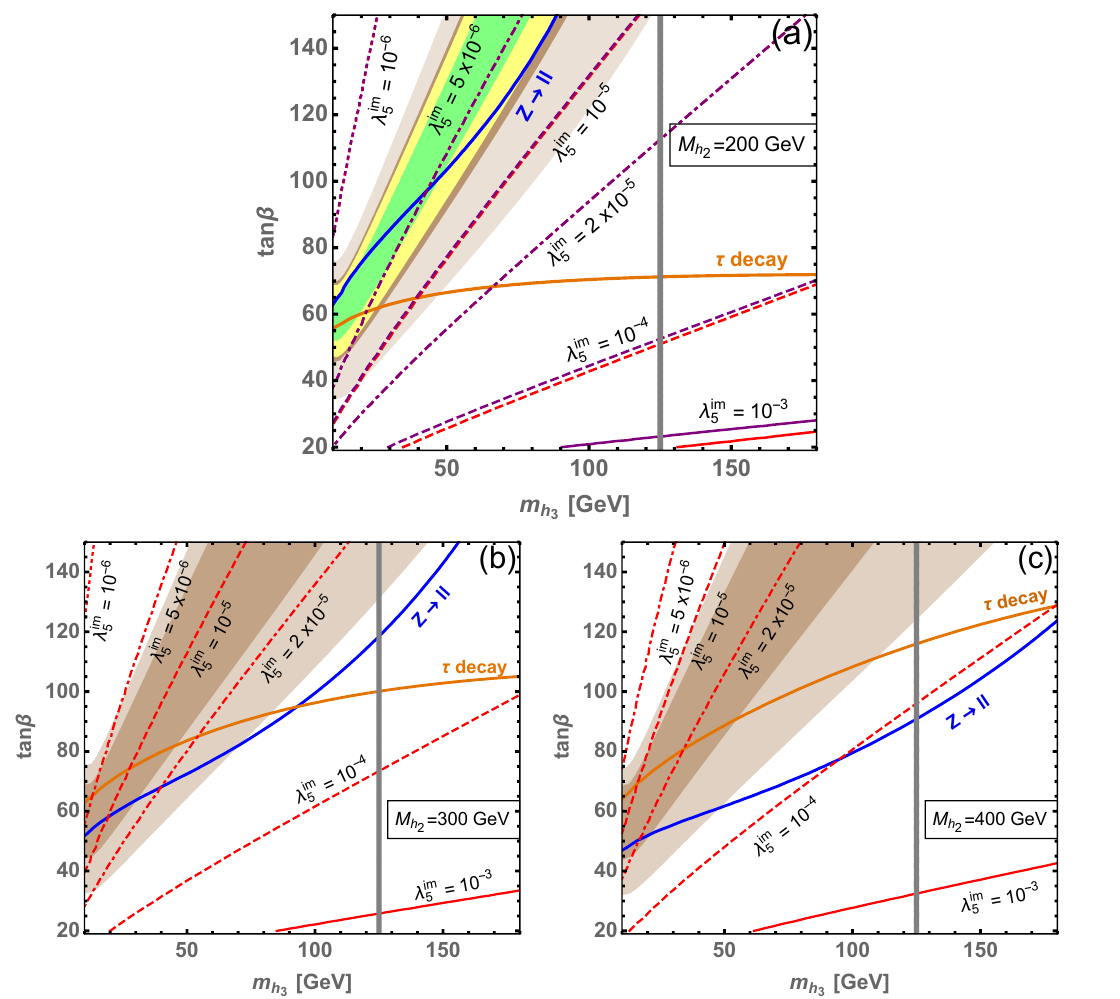
Figure 3 . Allowed parameter space in m h tan (cid:12) plane depicting all the constraints coming from 3 (cid:0) EDM, ( g 2) (cid:22) and lepton (cid:13)avor universality. The parameter Im( (cid:21) 5 ) is denoted as (cid:21) im in the plots. 5 (cid:0) both the RS and WS Yukawa couplings are allowed. The vertical gray bar in (cid:12)gure 3 depicts the region where h and the the SM Higgs h becomes degenerate and the approximate 3 1 expressions for mixing angles as in eq. (2.18) breaks down. In (cid:12)gure 3(b),(c) we have shown the allowed parameter space for m = m (cid:6) = 300 and 400 GeV and for simplicity h 2 h the future Fermilab limit is not shown. The light(dark) brown region explain the present ( g 2) anomaly at 2 (cid:27) (1 (cid:27) ). As we increase m the mixing angle sin (cid:11) decreases(see (cid:22) c h 2 (cid:0) eq. (2.18)) and comparatively large Im( (cid:21) ) is allowed for a given m and tan (cid:12) . Note that 5 h 3 for m 250 GeV, RS Yukawa couplings are disfavored because they cannot satisfy the h 2 (cid:21) perturbativity and vacuum stability bounds as in eq. (3.1). Hence for heavier m we have h 2 only WS Yukawa